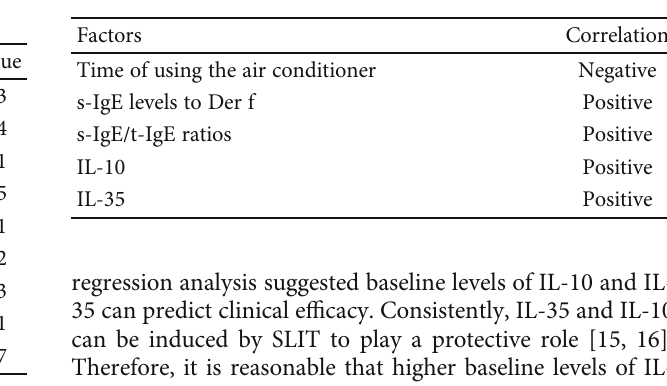
Table 7: Factors associated with clinical response to